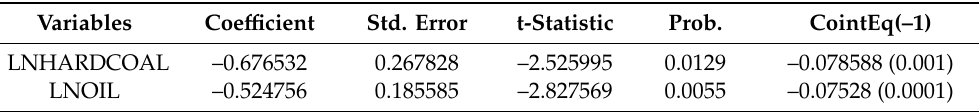
Table 12. ARDL cointegrating and long-term form, long-term coe ffi cients.